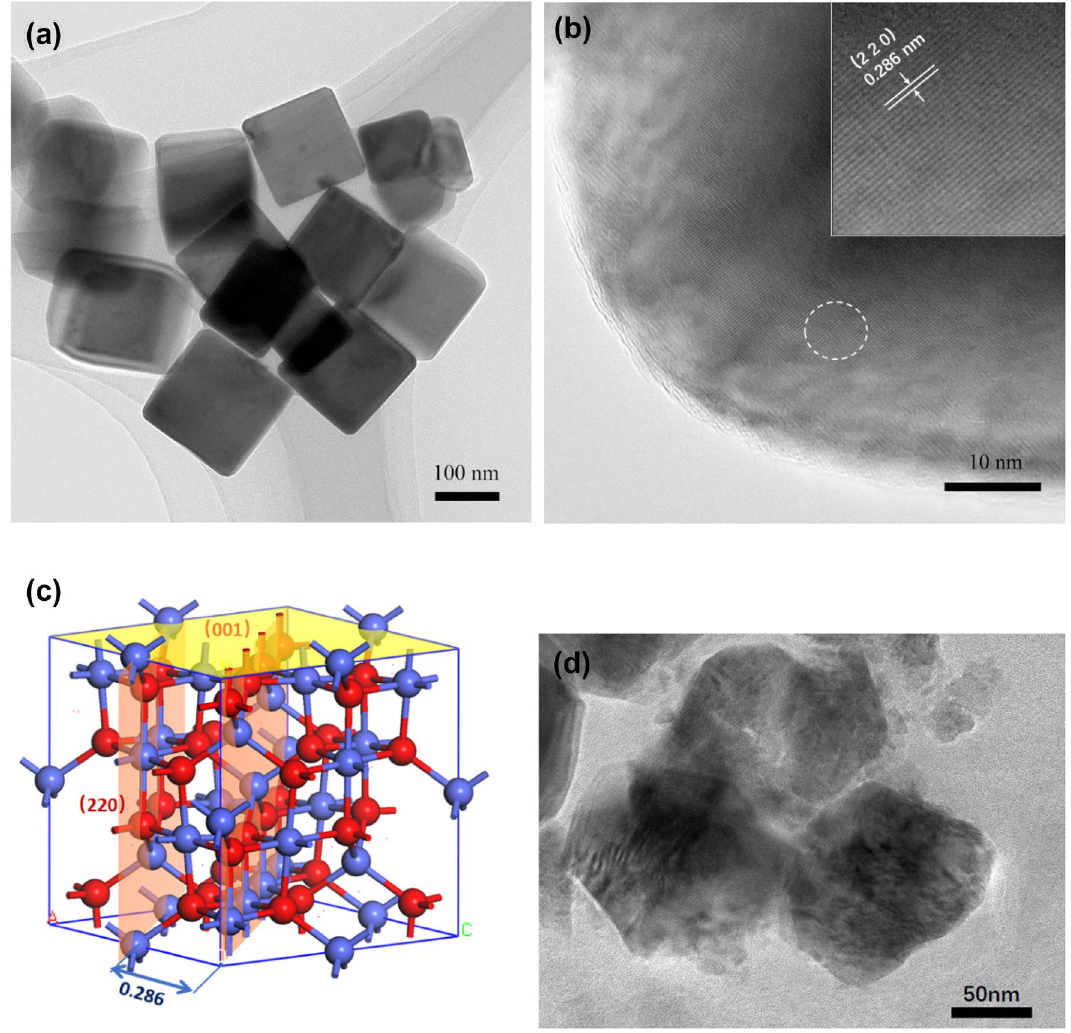
Fig. 2 a TEM images of Co 3 O 4 nanocubes. b HRTEM of a Co 3 O 4 nanocube. c Schematic of a (001) surface of Co 3 O 4 nanocubes. d TEM images of commercial Co 3 O 4